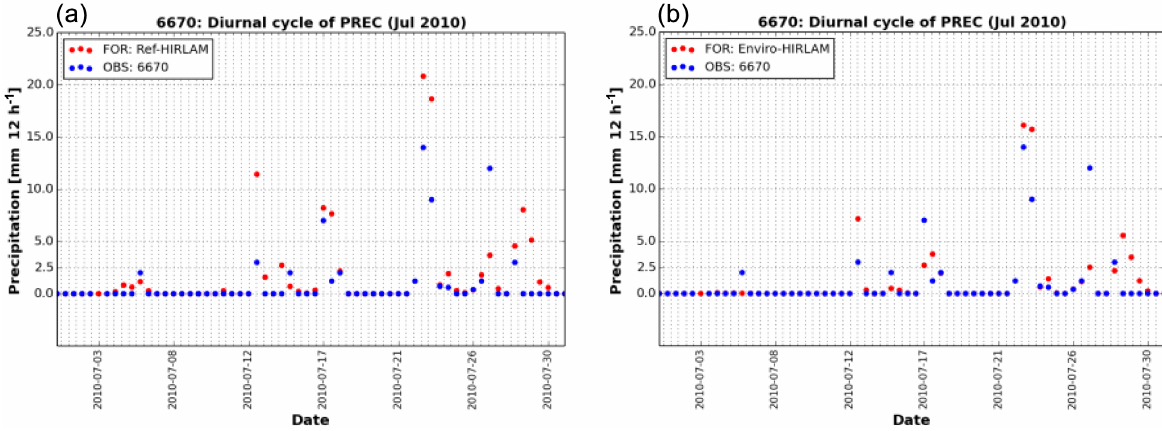
Figure 8. Precipitation amount (12h accumulated) of Reference-HIRLAM (a) and Enviro-HIRLAM with aerosol–cloud interactions (b) versus surface synoptic observations at WMO station 6670 in Zurich, Switzerland (lat: 47.47; long: 8.53), during July